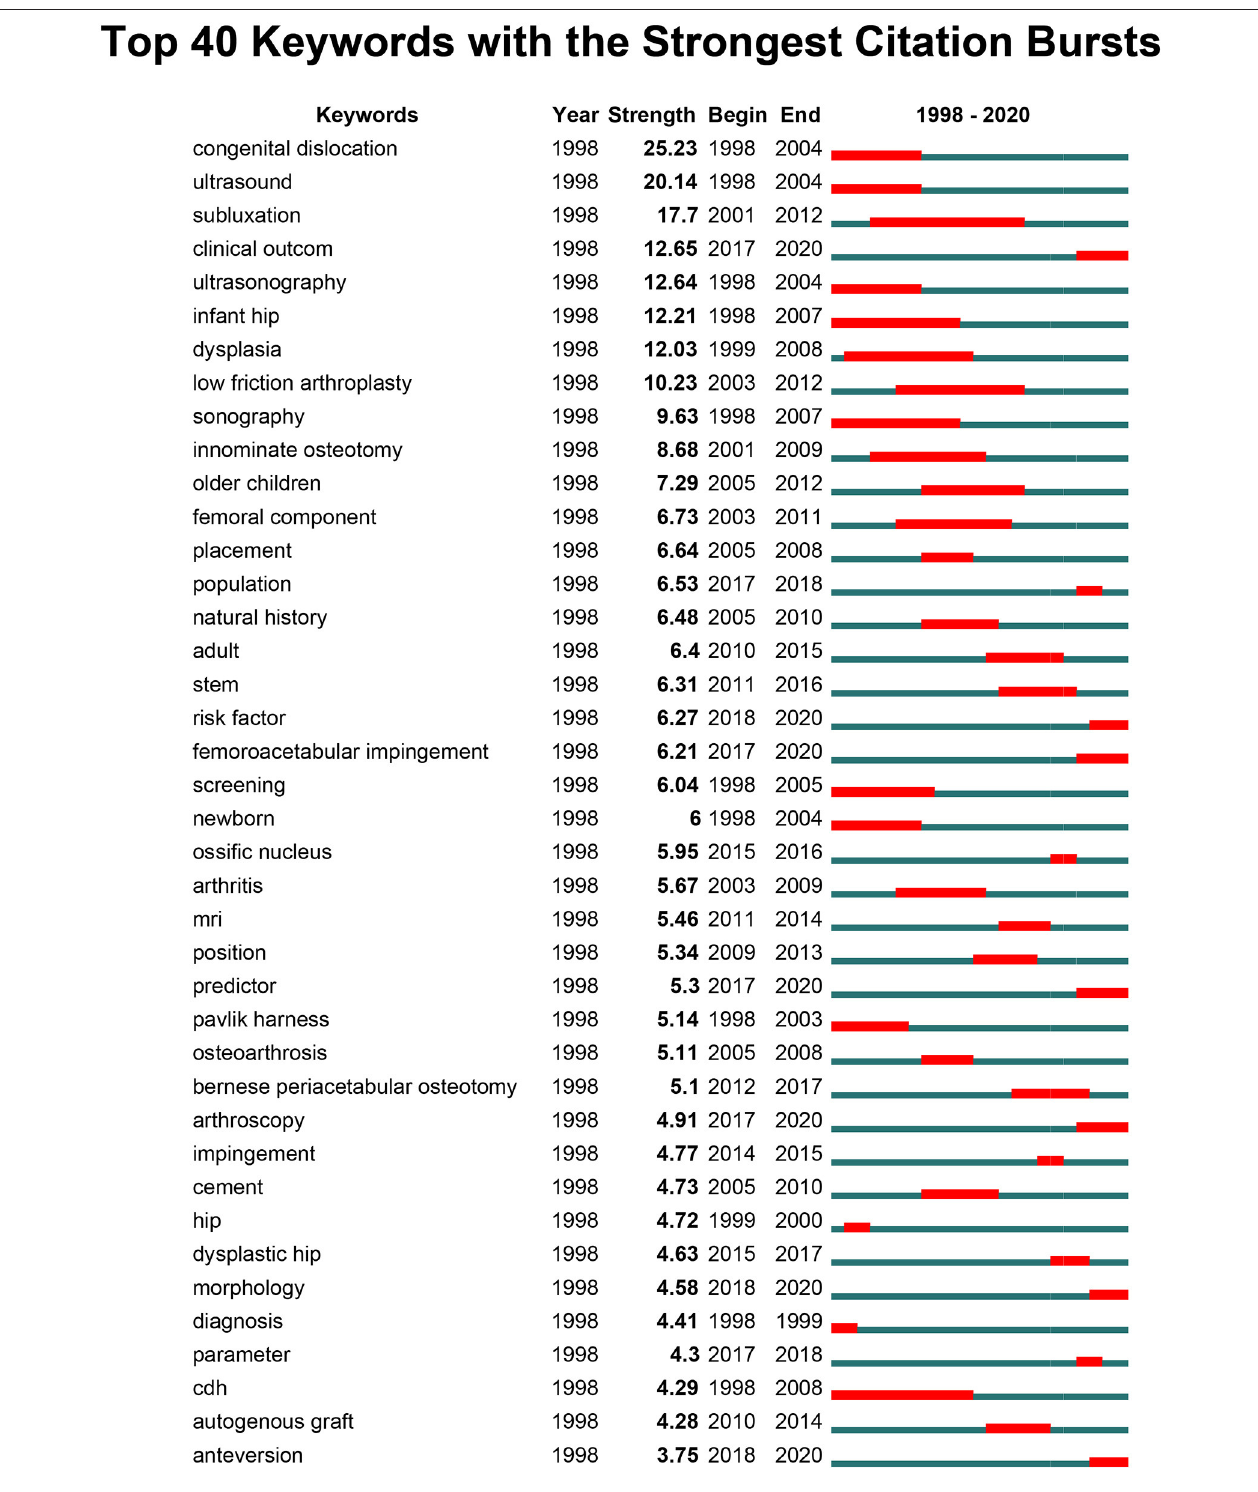
FIGURE 9 | The top 40 keywords with the strongest citation bursts from 1998 to 2020. The blue line indicates the time interval, while the red line represents the duration in which a keyword was detected the strongest citation burst.